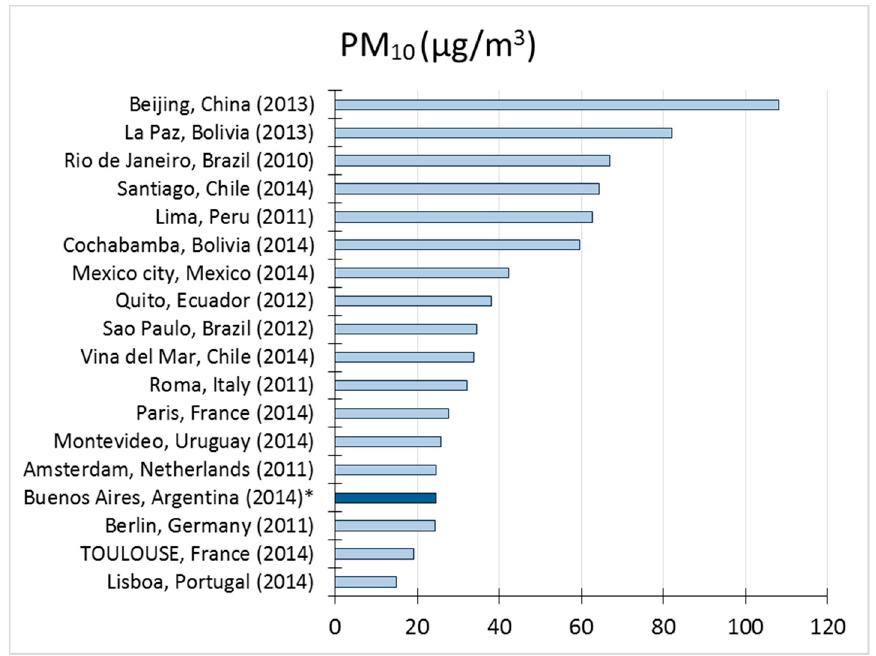
Figure 5. Comparison of the PM 10 annual average in different cities of the world according to the 2016 updated WHO database. * Buenos Aires data in this chart corresponds to Centenario station